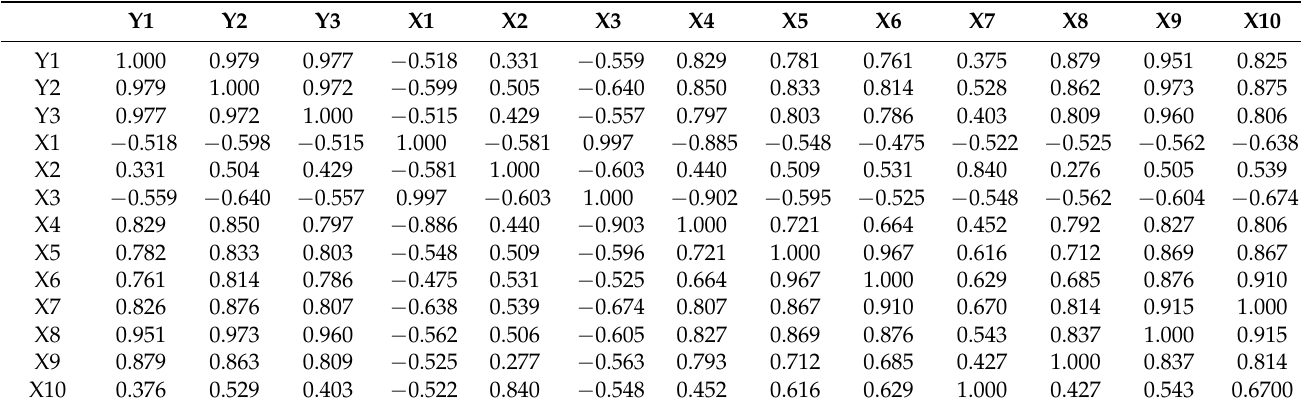
Table 10. Correlation analysis between dependent and independent variables.